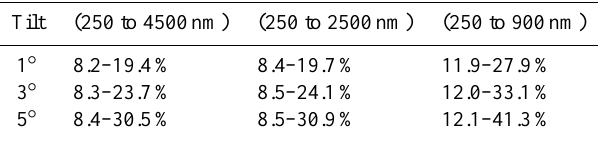
Table 2. The diffuse proportion ( P dif ) of global irradiance. Vari- ability within the ranges presented is a function of sensor pointing azimuth as well as solar zenith angle. The simulations test a range of solar zenith angles from noon (0 ◦ ) to near-dusk (80 ◦ ), simulated in 5 ◦ steps.